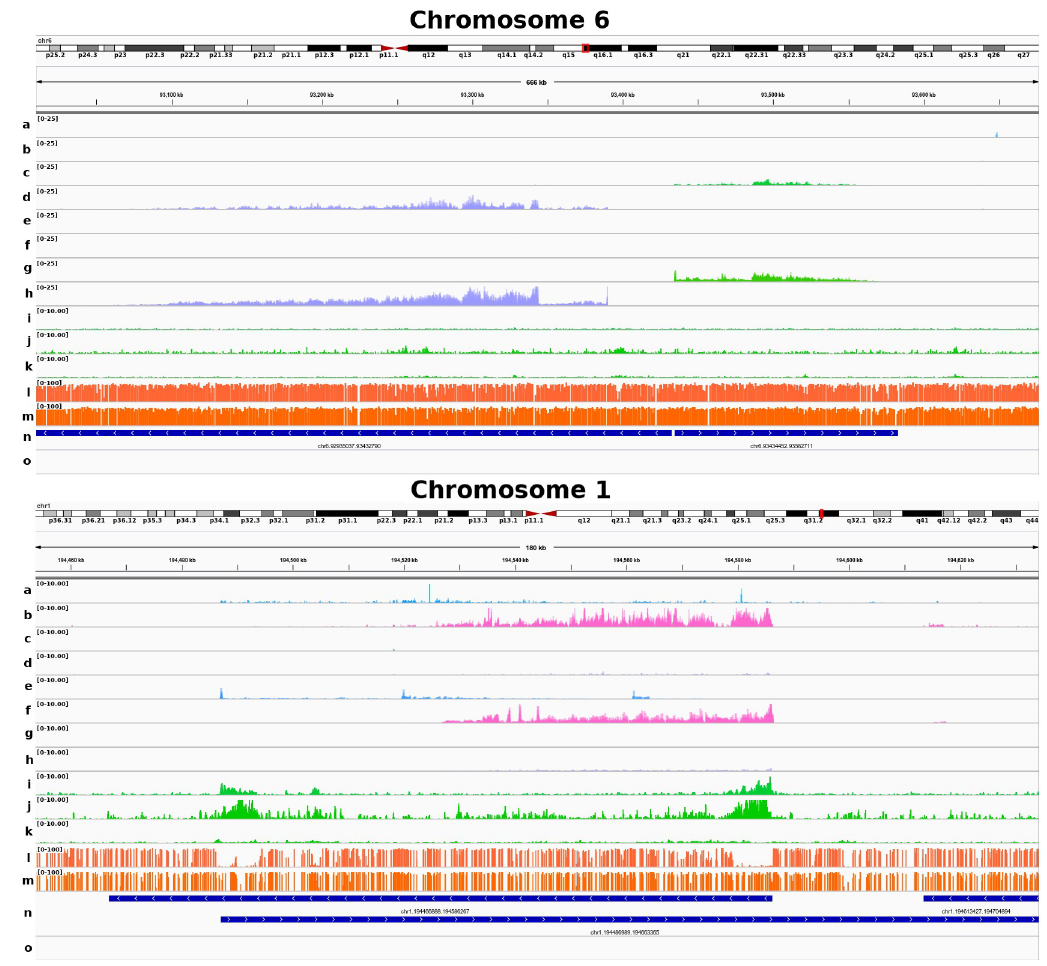
Fig 3. Genome wide tracks of gene expression, active histone marks and CpG methylation of subtype-specific cALL vlincRNAs. Epigenetic tracks of vlincRNAs expressed in specific subtypes. Top, HHD-specific vlincRNAs expressed on chromosome 6 in both the SOLiD and Illumina sequencing platforms. Bottom, t(12;21)-specific vlincRNAs expressed on chromosome 1 in both the SOLiD and Illumina sequencing platforms. Splicing patterns are more clearly defined with Illumina RNA-seq data. (A,B) Normalized read coverage of t(12;21) vlincRNA expression (SOLiD platform, + and—strands). (C,D) Normalized read coverage of HHD vlincRNA expression (SOLiD platform, + and—strands). (E,F) Normalized read coverage of t (12;21) vlincRNA expression (Illumina platform, + and—strands). (G,H) Normalized read coverage of HHD expression (Illumina, + and—strands). (I,J,K) Normalized read coverage of the H3K4me3, H3K27ac and H3K4me1 ChIP-seq histone marks in the t(12;21) pool sample. (L,M) WGBS methylation levels of the merged t(12;21) cases (n = 3) and the CD10 + CD19 + control cells. (n) Coordinates of vlincRNA transcripts (n = 288) found in the discovery samples (n = 68). (o) RefSeq gene annotations.